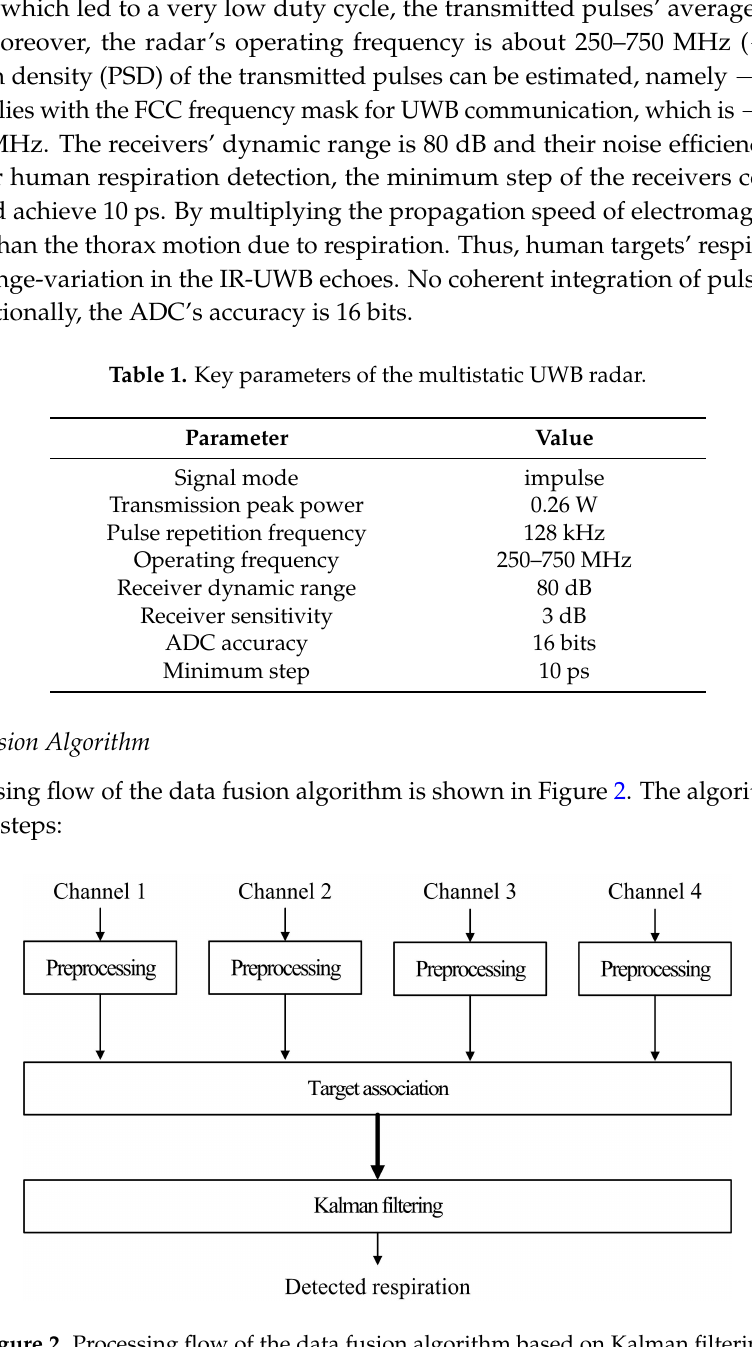
Figure 2. Processing flow of the data fusion algorithm based on Kalman filtering.